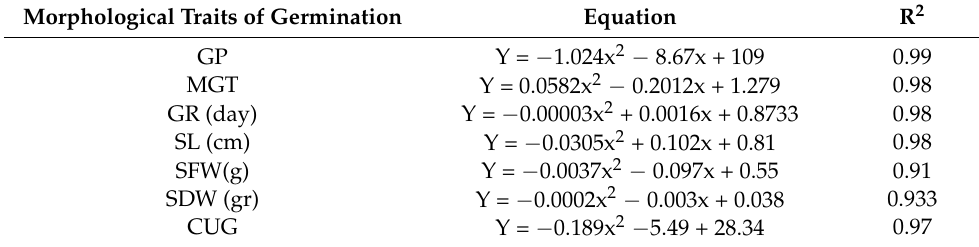
Table 3. Reductions of GP, MTG, GR, SL, SFW, SDW, and CUG of Hibiscus tea seeds with increasing